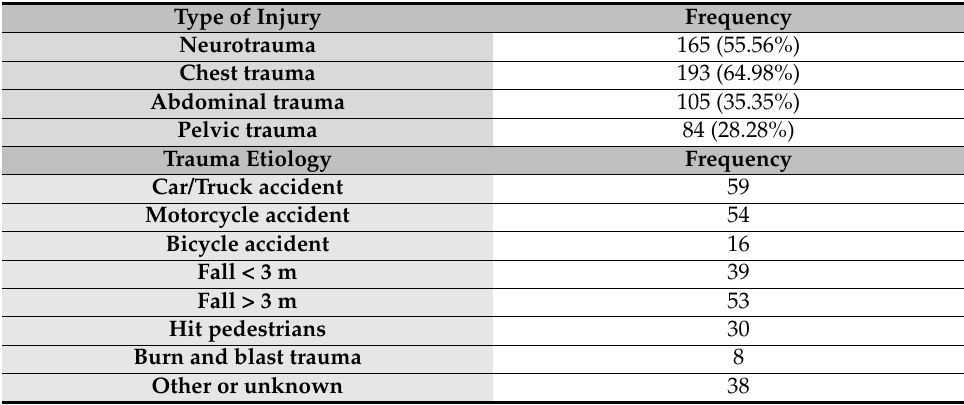
Table 2. Type of injury and trauma